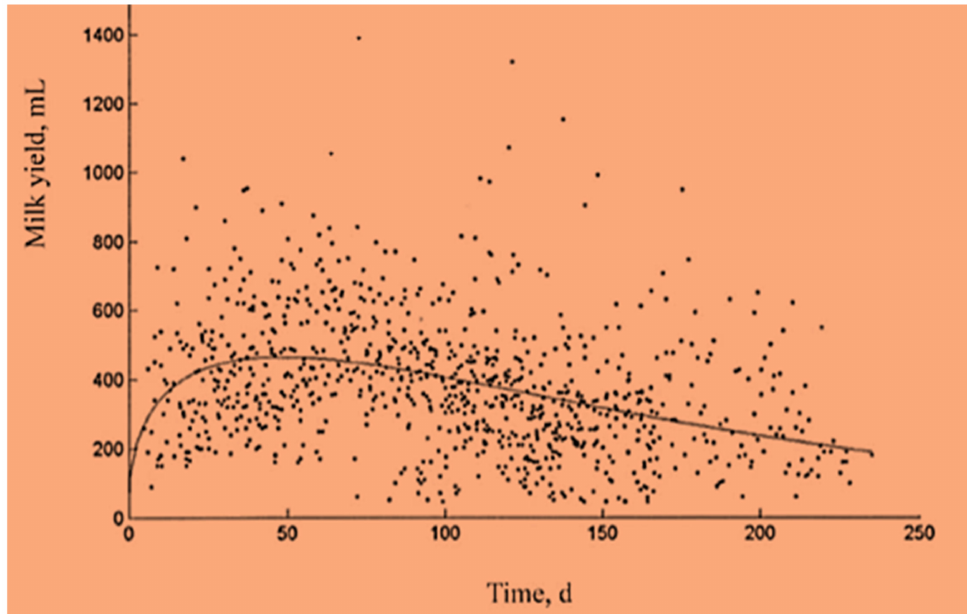
Figure 1. Lactation curve from milk yield data (morning milk) in donkey mares ( n = 12) with regression [31], by application of Wood’s model (Wood, 1967): Y t = a × t b × e − ct (r 2 = 0.11), where Y is milk yield on day t of lactation, a is the constant level of initial yield, b is the rate of increase to peak, e is the mathematical constant, c is the rate of decline after peak and peak in days (t) is given by